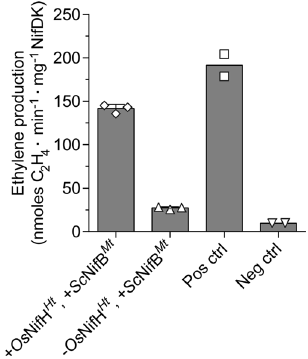
Fig. 4 NifB-dependent in vitro FeMo-co synthesis using Os NifH Ht and Sc NifB Mt . In vitro FeMo-co synthesis was performed by combining